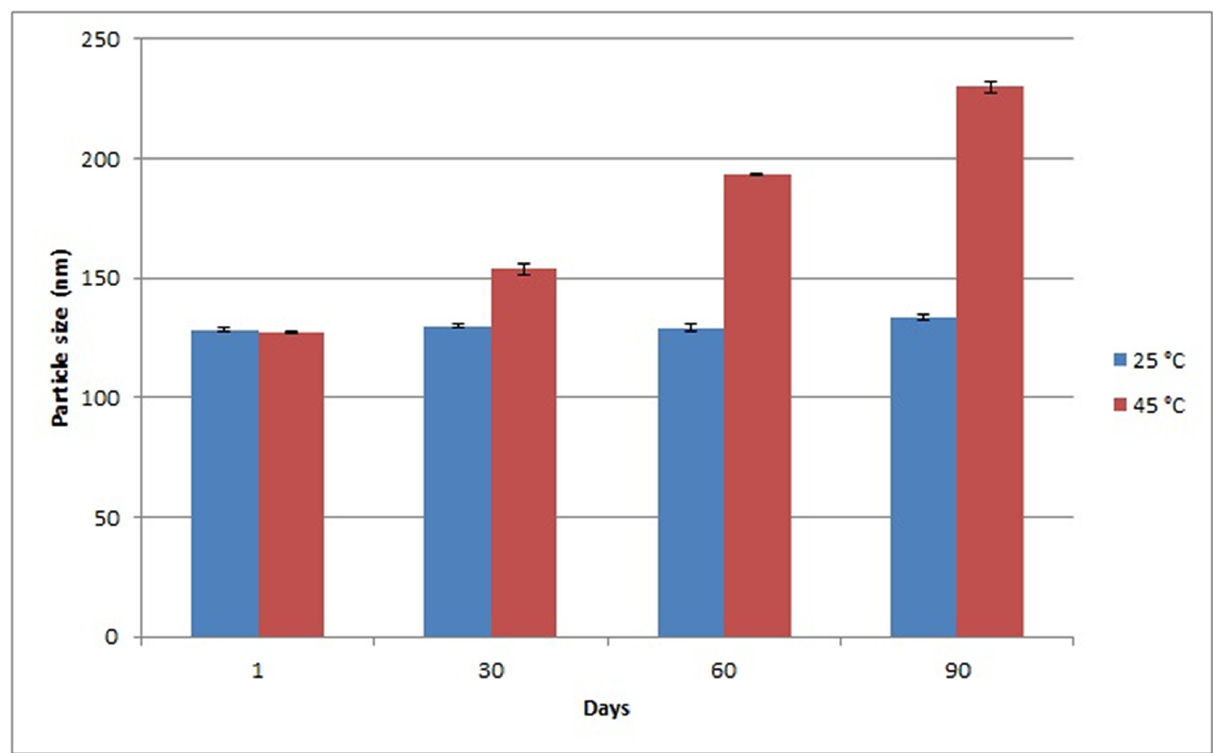
Fig 6. Particle size changes (90 days) of VCOCP which was stable at 25°C and